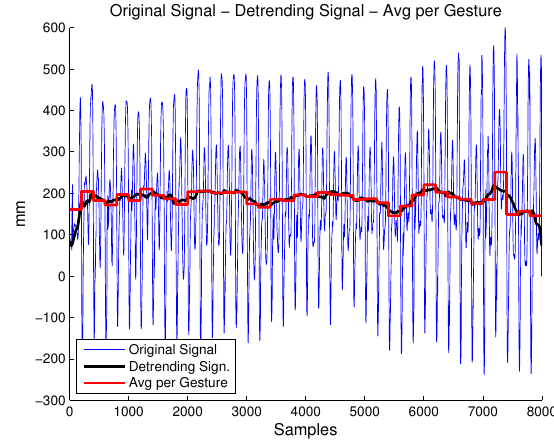
Figure 3. Differences between 2 normalisation methods. Method 1 uses the detrending signal (black) for normalisation. Method 2 uses the average per basic gesture (red) for normalisation .